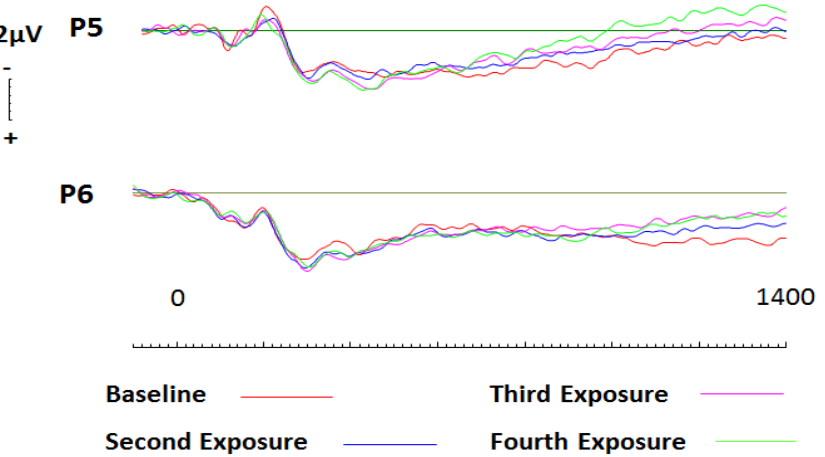
Figure 10. ERPs generated for all filler brands during each condition across frontal electrode sites AF3 and AF4. No changes between sessions were evident.